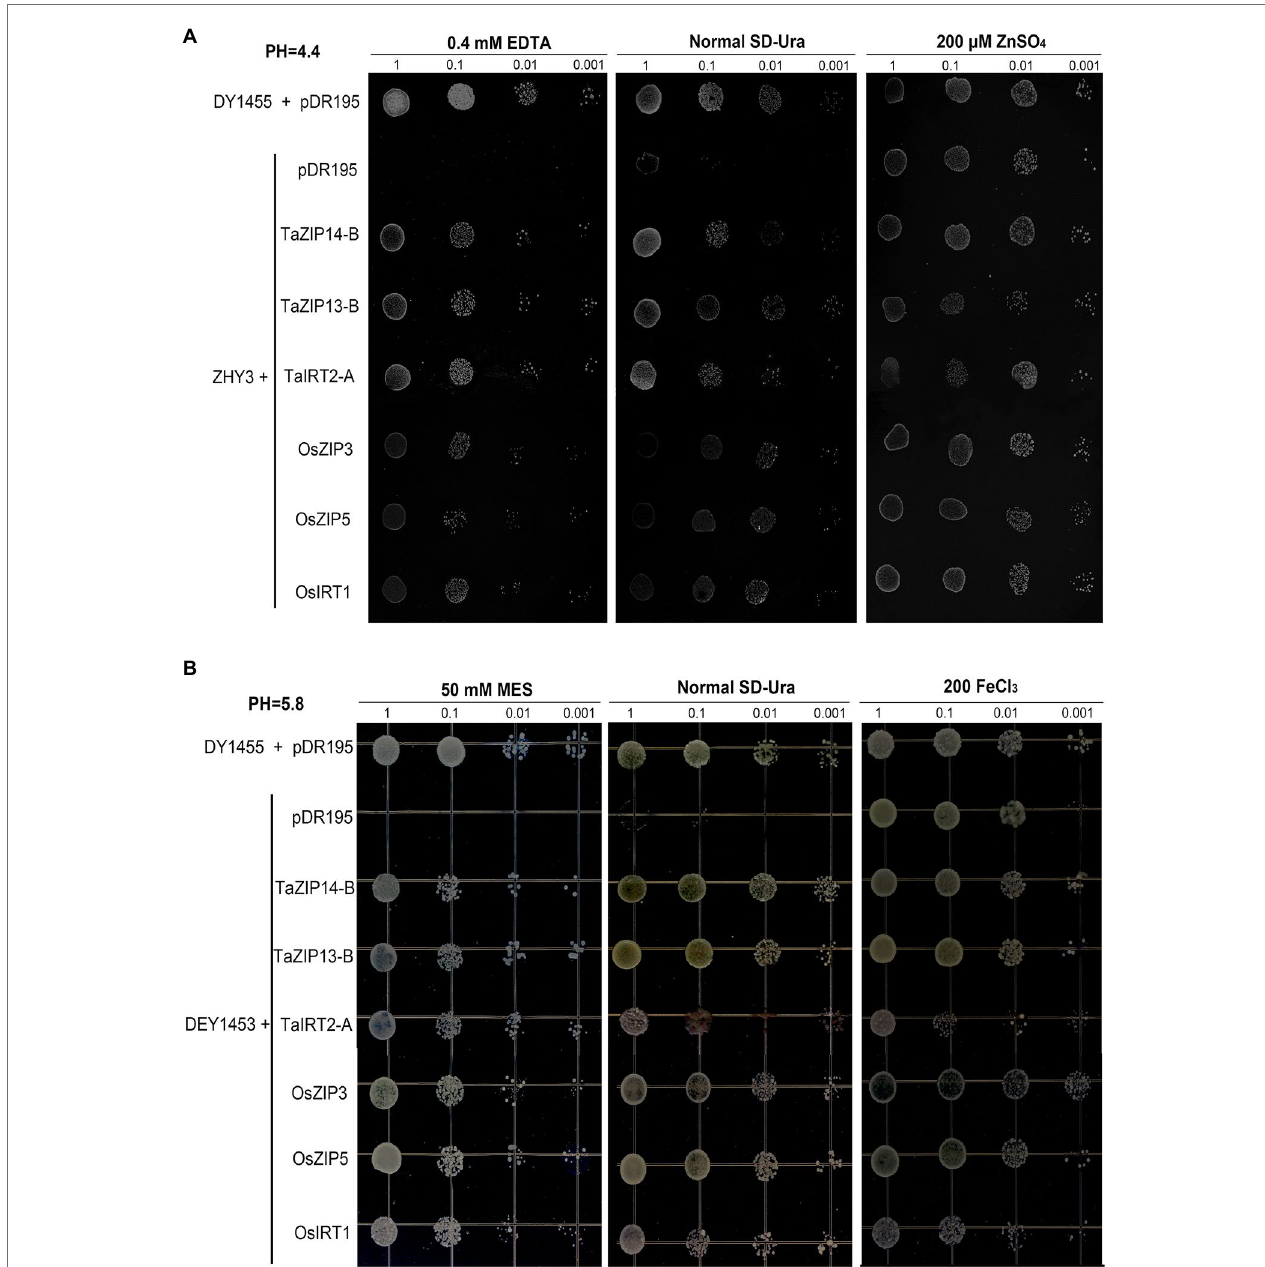
FIGURE 7 | Functional complementation of yeast Zn and Fe transport mutants by TaZIPs under different pH conditions. (A) The Zn transport mutant zrt1zrt2 (pH 4.4); (B) the Fe transport mutant fet3fet4 (pH 5.5–5.8). Mutant transformed with the expression vector pDR195 carrying TaIRT2-A, TaZIP14-B , or TaZIP13-B or a functionally characterized ZIP gene, OsZIP5, OsZIP8 , or OsIRT1 . The wild-type (WT) strain DY1455 transformed with pDR195 was used as a positive control, and the yeast zrt1zrt2 or fet3fet4 mutant transformed with the empty vector pDR195 was used as a negative control. The transformed yeast cells were grown under different metal conditions as indicated, and the transformed fet3fet4 was grown on medium with pH 5.8. Cell concentration was adjusted to OD 600 = 1 and serial dilutions (1.0, 0.1, 0.01, and 0.001) were made. For assay, 5 μ l of each dilution was spotted on plates and grown for 6 days at 30 °